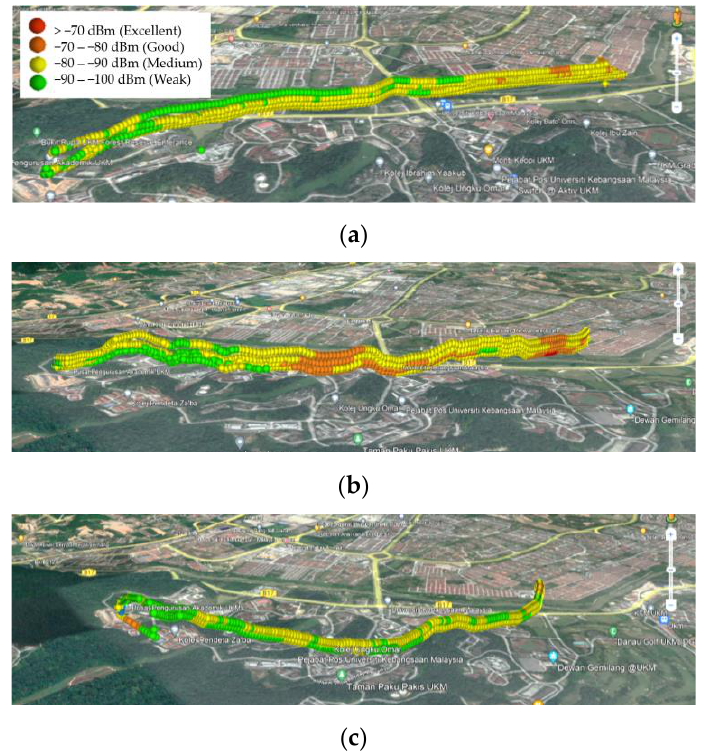
Figure 17. RSRP measurements for the aerial drive test on the UKM campus at different heights (65, 85, 105, and 125 m) and different routes: ( a ) Route I, ( b ) Route II, and ( c ) Route III.